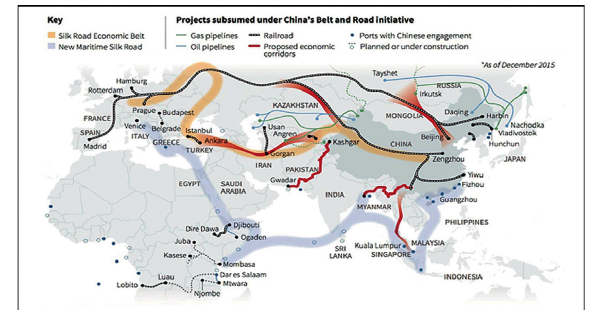
Figure 1: BRI projects and region map